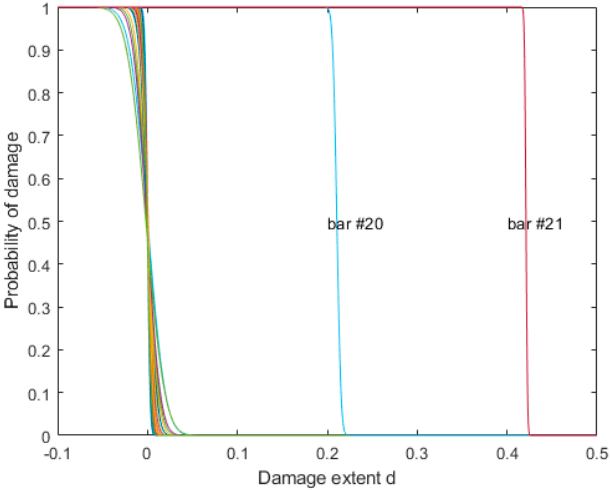
Figure 9. Probability curve of damage extent for truss model.